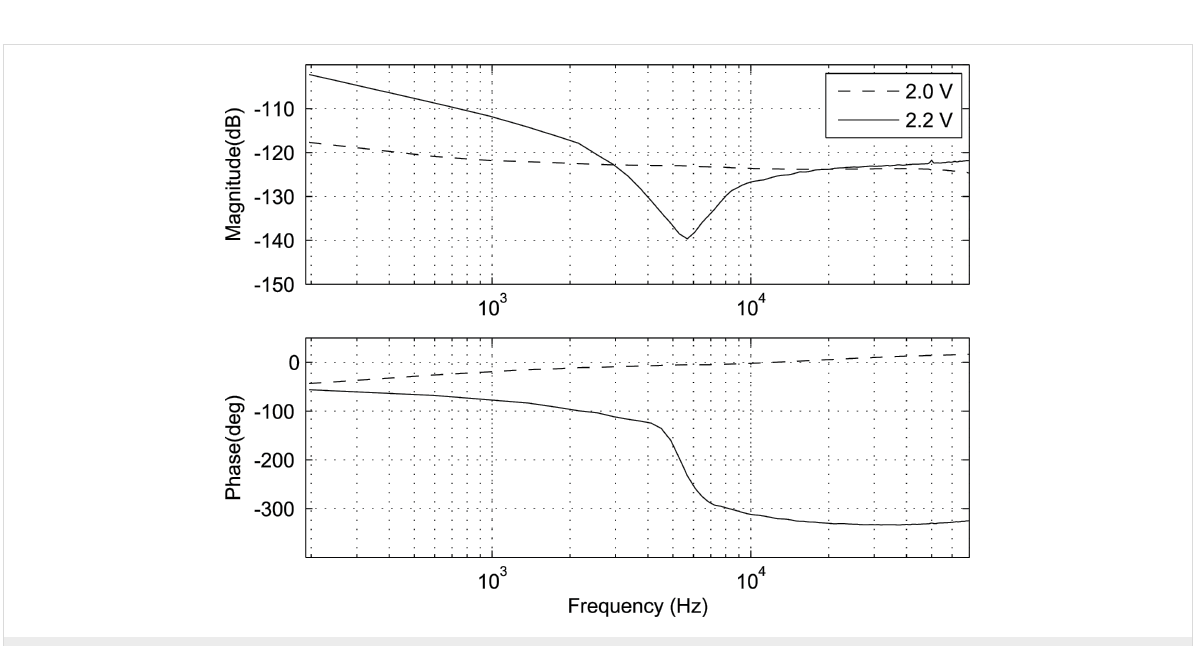
Figure 11: Admittance spectroscopy for gate voltages from 1.0 V to 3.0 V.